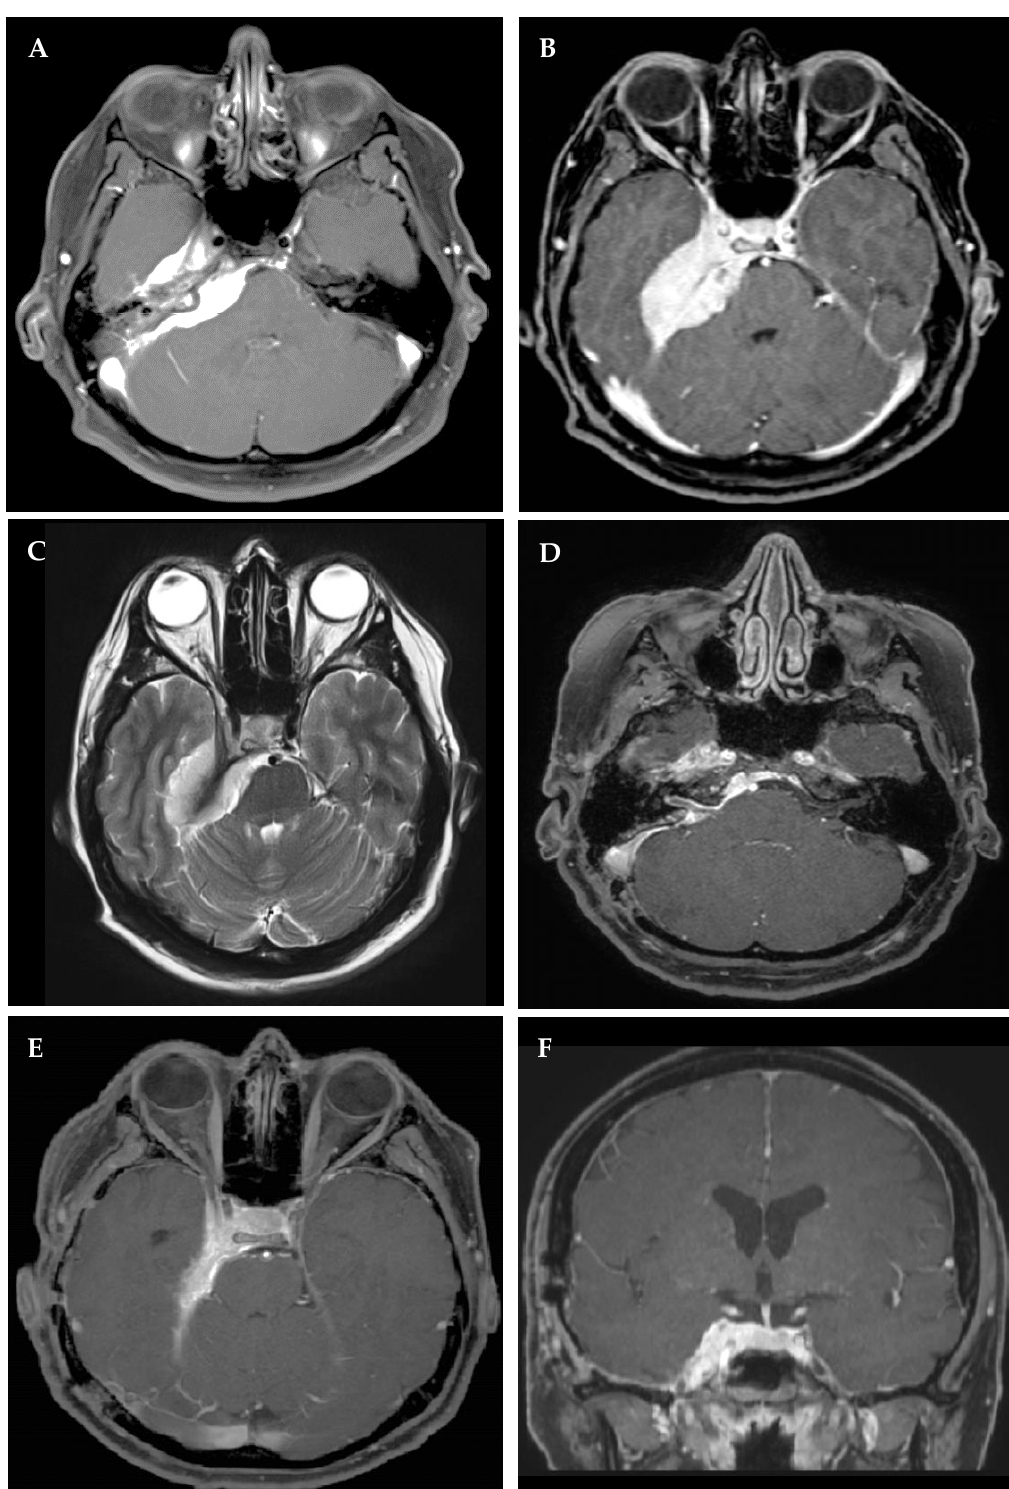
Figure 3. Right petroclival meningioma in a 48-year-old female who presented with tinnitus, diplopia and vertigo, undergoing a staged resection by (1) retrosigmoid and (2) pterional craniotomy. Preoperative magnetic resonance imaging (MRI) in axial contrast-enhanced T1 ( A , B ) and T2 ( C ) I sequences demonstrating compression of the brain stem and invasion of the cavernous sinus. Residual tumor within cavernous sinus and tentorial edge on postoperative MRI ( D – F ). A transient palsy of the 4th nerve was noted after the second procedure, resolving fully on follow-up.